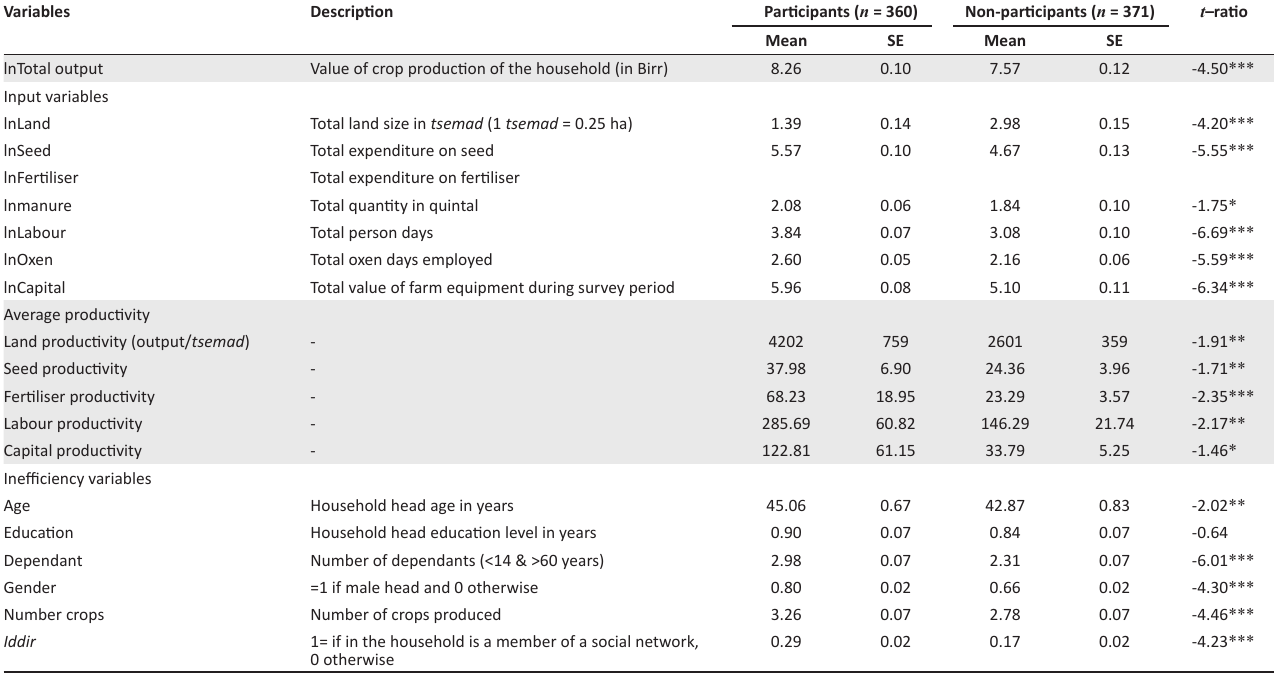
TABLE 1: Summary statistics of the variables used in the analysis. Variables